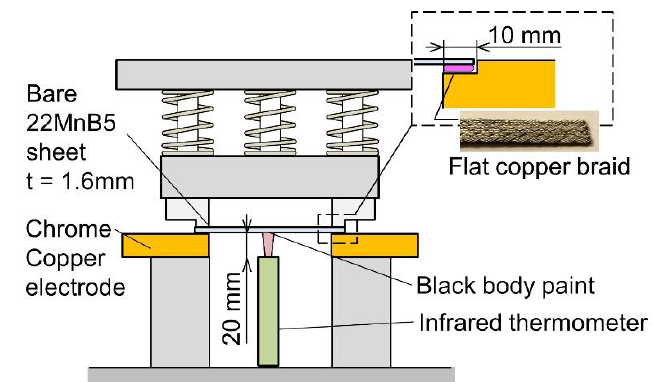
Figure 3. Resistance heating equipment for hot stamping of hat-shaped bending.